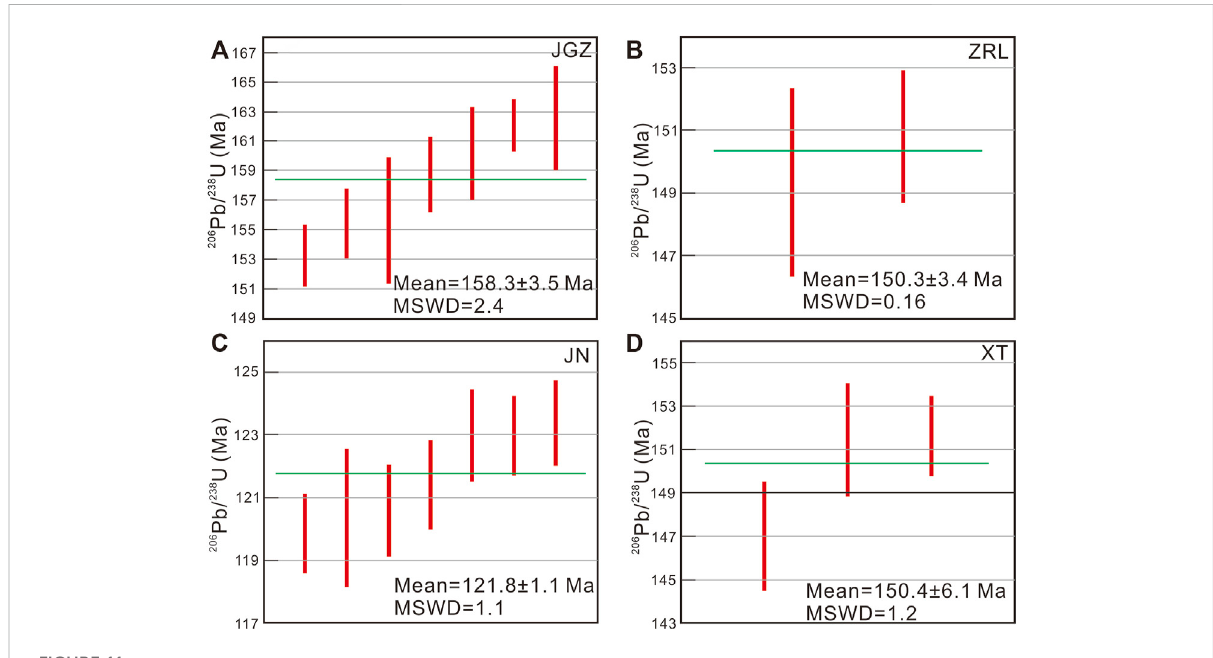
FIGURE 11 Weighted average ages of the youngest detrital zircons from the Late Mesozoic sedimentary rocks in the western Shandong province (A,B and D) and Tanlu fault zone (C)